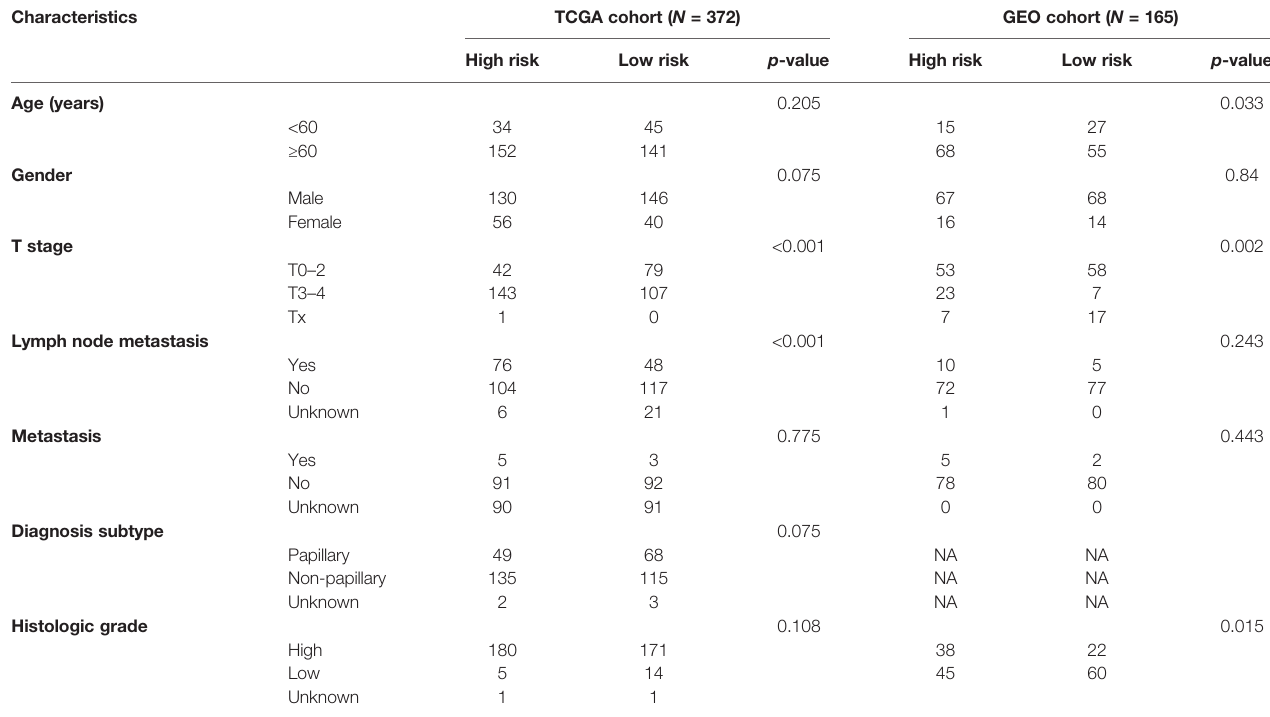
TABLE 2 | Baseline characteristics of the patients in different risk groups in the TCGA cohort and the GEO cohort.